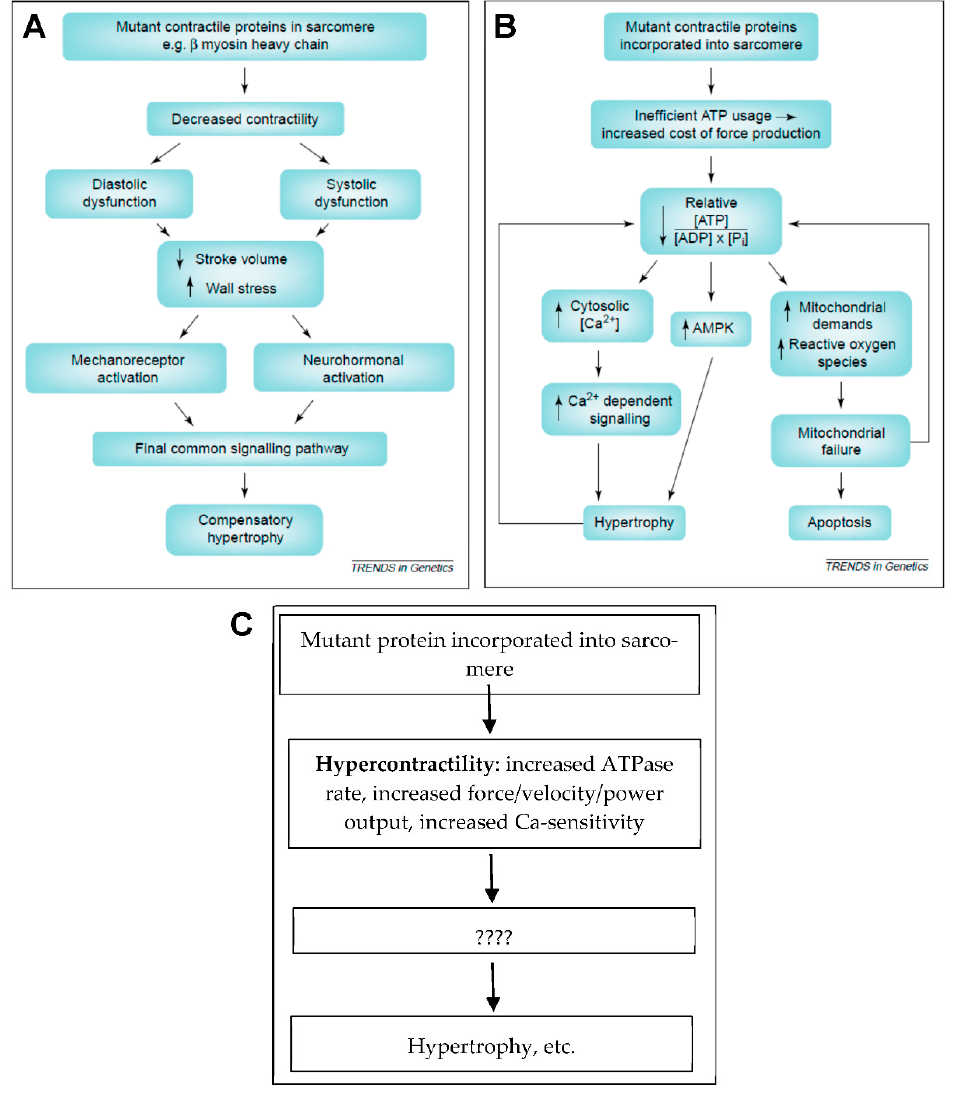
Figure 5. Hypocontractility, hypercontractility and energy depletion/energy inefficiency. ( A ) Hypocontractility hypothesis as presented (and partly refuted) in Reference [11]. ( B ) The hypothesis presented in Reference [11] that inefficient energy usage with energy depletion leads to pathologic remodeling. ( C ) Hypercontractility hypothesis where hypercontractility, in different forms as indi- cated, represents the primary mutation-induced functional change that, via secondary effects (????; e.g., energy depletion), leads to pathologic remodeling of the left ventricle. Panels ( A , B ) reproduced from Reference [11] with permission from